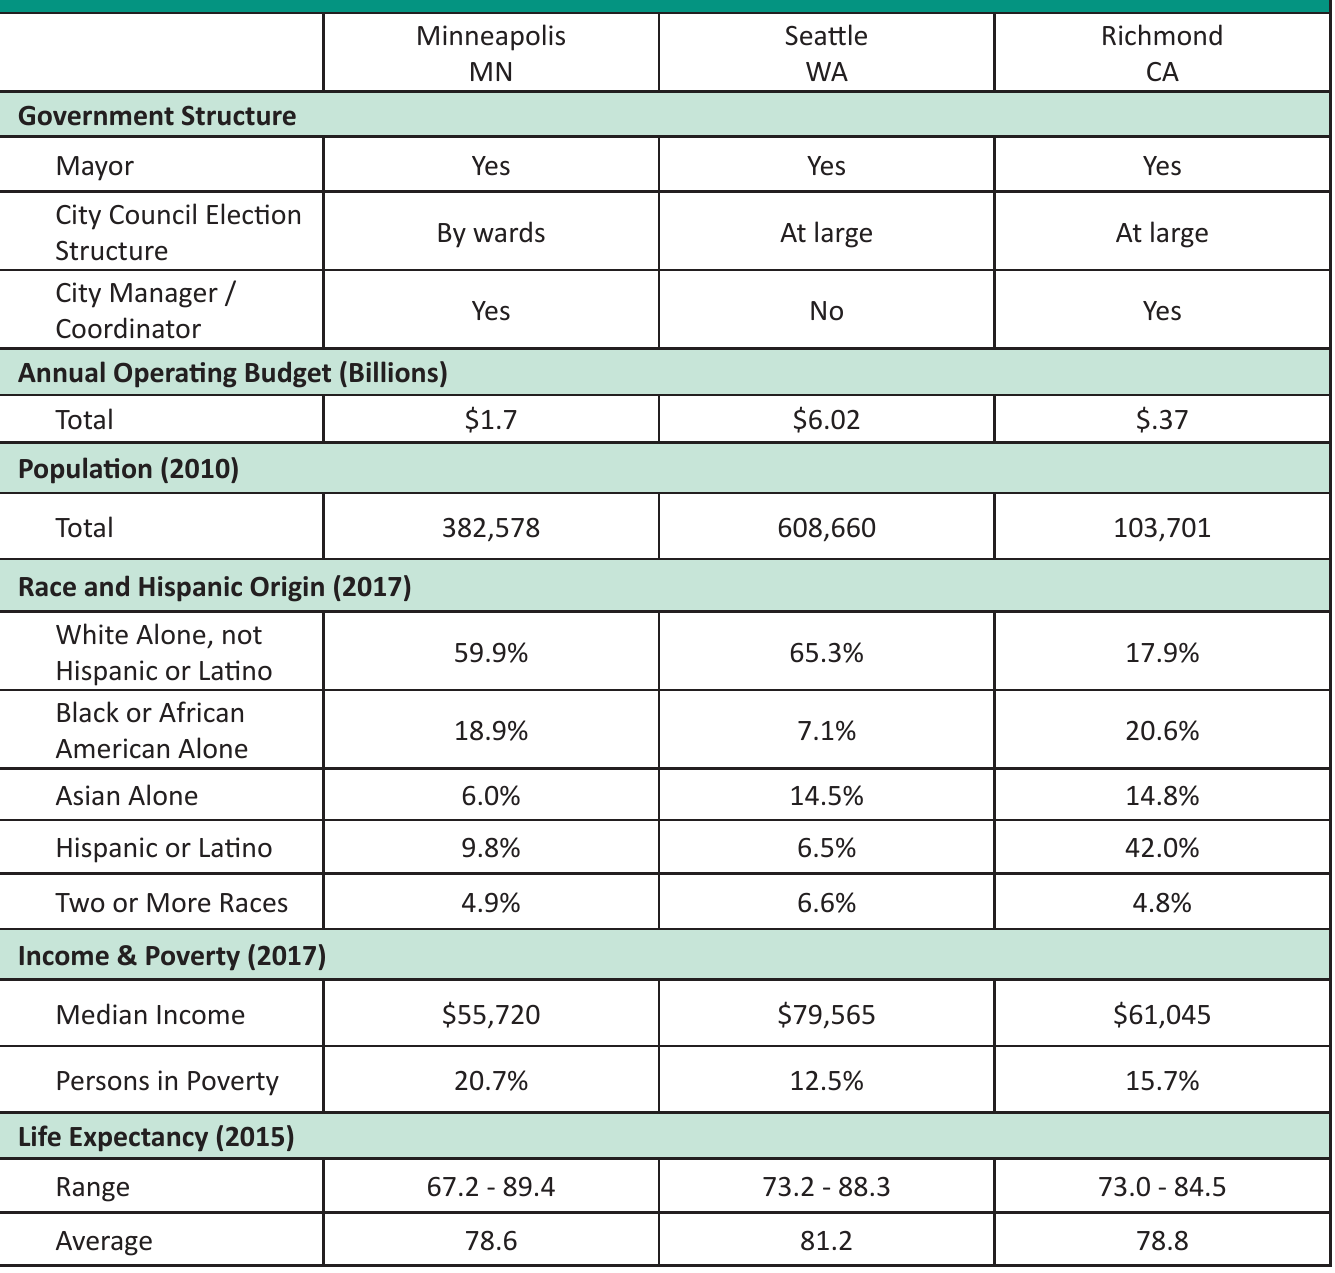
Table 1. Case Study Community Profiles